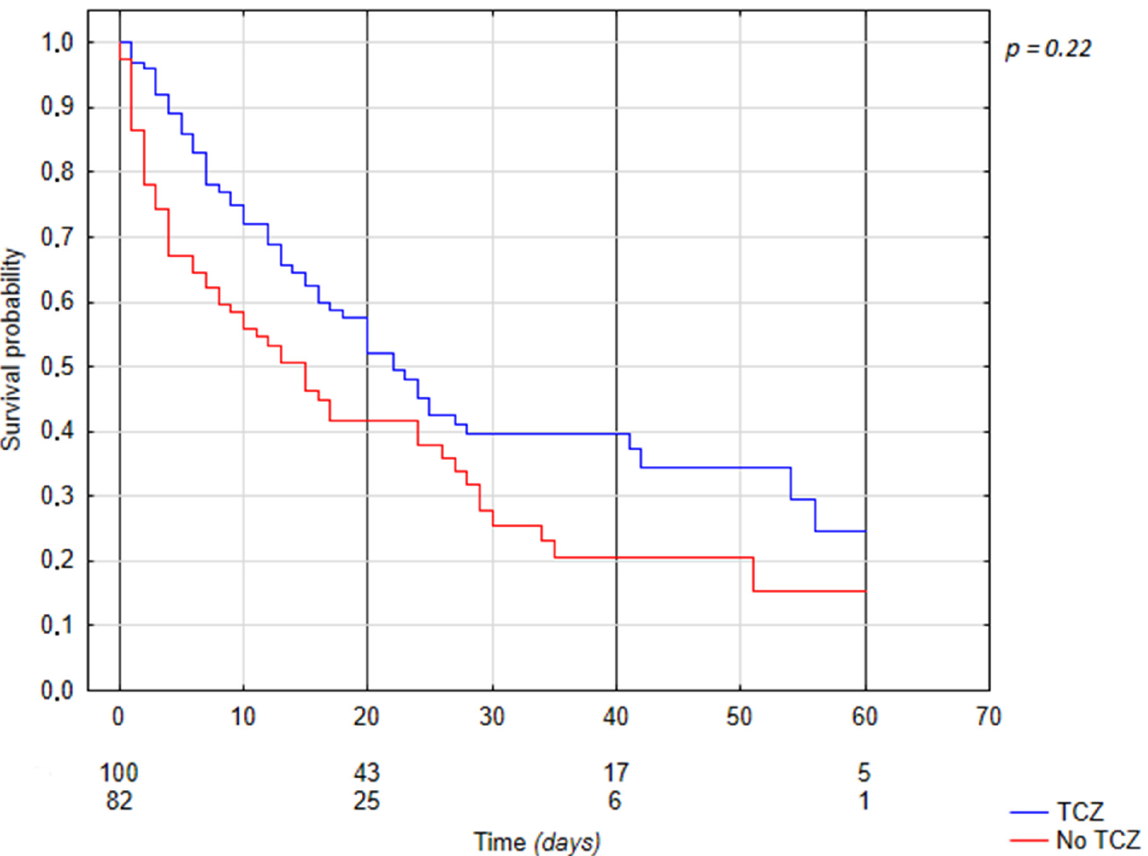
Figure 2. Kaplan–Meier curves displaying the estimated survival probability for TCZ-related treatment of patients with severe or critical COVID-19-related pneumonia. We created multivariate Cox proportional hazards models for all statistically significant factors and for the administration of tocilizumab. As diabetes appears to be an important factor, we added it as an additional variable. In multivariate proportional Cox